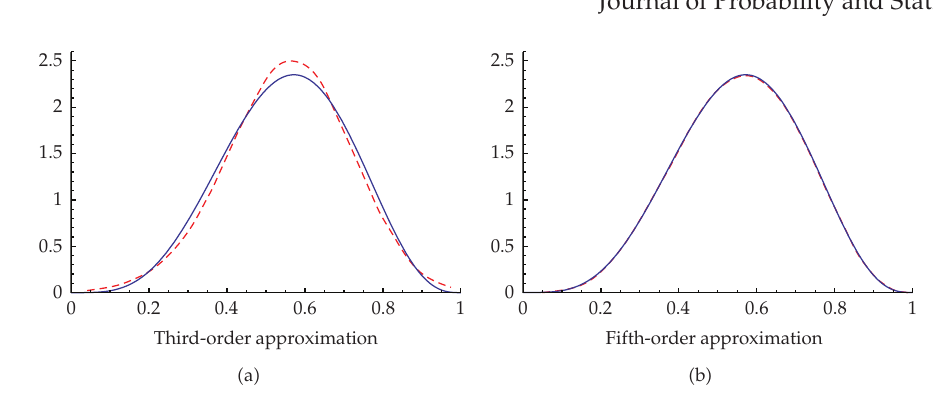
Figure 3: Third- and fifth-order standard normal-based polynomial approximations (cid:2) dashed lines (cid:3) of a Beta (cid:2) α (cid:7) 5, β (cid:7) 4 (cid:3) distribution. The L -moment ratios for this Beta distribution are given in Table 3. The fifth-order polynomial coe ffi cients are c 1 (cid:7) . 02697, c 2 (cid:7) 1 . 071, c 3 (cid:7) − . 0297, c 4 (cid:7) − . 0312, c 5 (cid:7) . 0009, and c 6 (cid:7) . 00065. The third-order polynomial coe ffi cients are c 1 (cid:7) . 02576, c 2 (cid:7) 0 . 9993, c 3 (cid:7) − . 02576, and c 4 (cid:7) . 00027.